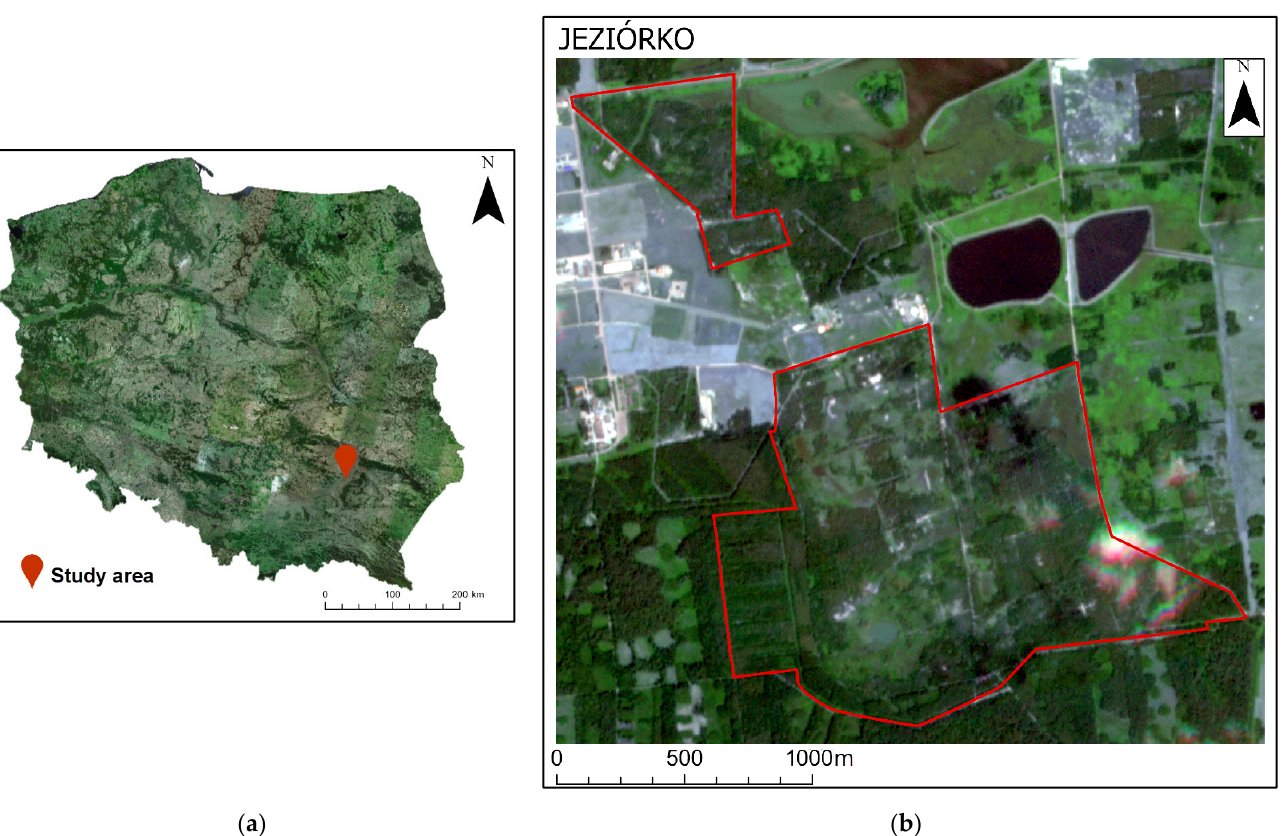
Figure 1. The research area: ( a ) general map of Poland with the localization of the study area; ( b ) analyzed area (red polygon) as a part of the former sulfur mine Jeziórko terrain (PlanetScope imagery, 2019).